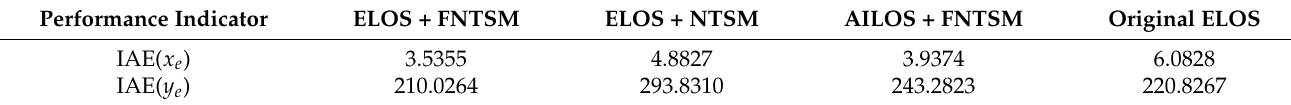
Table 2. Performance indicator of path-following